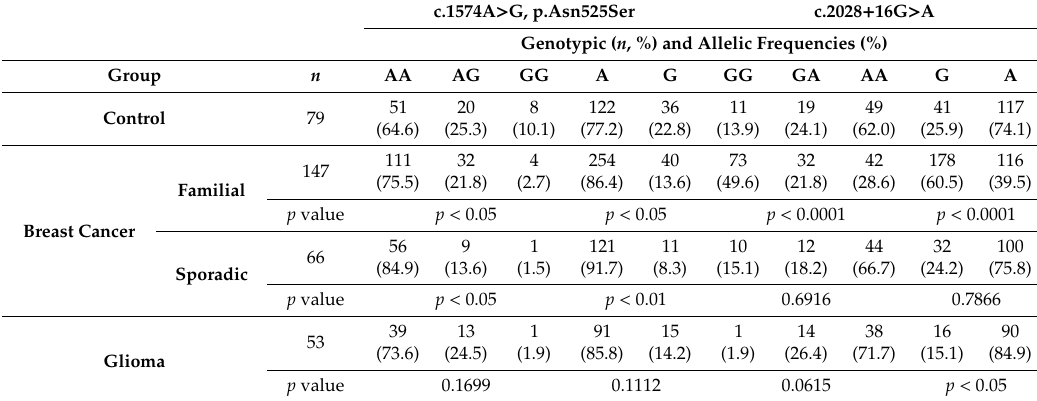
Table 2. Comparative analysis of germline CLSPN c.1574A > G and c.2028 + 16G > A variants between control individuals, and patients with breast cancer (familial and sporadic forms) or glioma tumours.